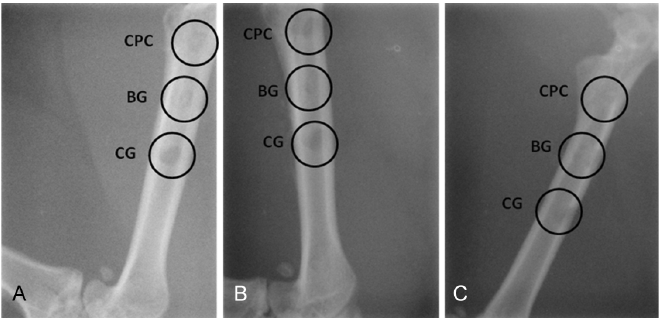
FIGURE 2 - ( A ) Digital radiographic image of the rat left femur 7 days after grafting. ( B ) Digital radiographic image of the rat left femur 15 days after grafting. ( C ) Digital radiographic image of the rat left femur 30 days after grafting. Calcium phosphate cement (CPC), bioactive glass (BG) and no material (control group CG).